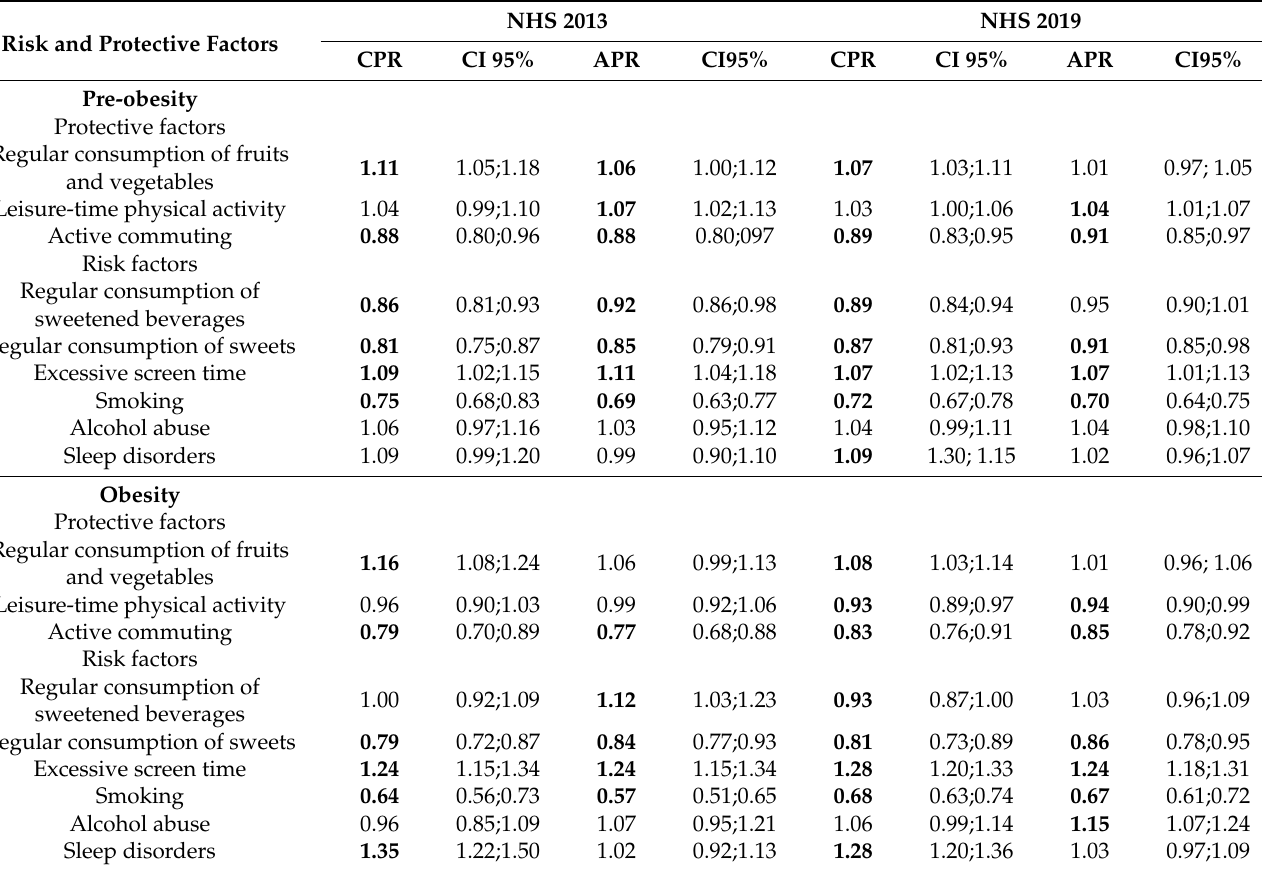
Table 3. Association coefficients (crude and adjusted) obtained in Poisson regression models to investigate the association of risk and protective factors according to nutritional status of